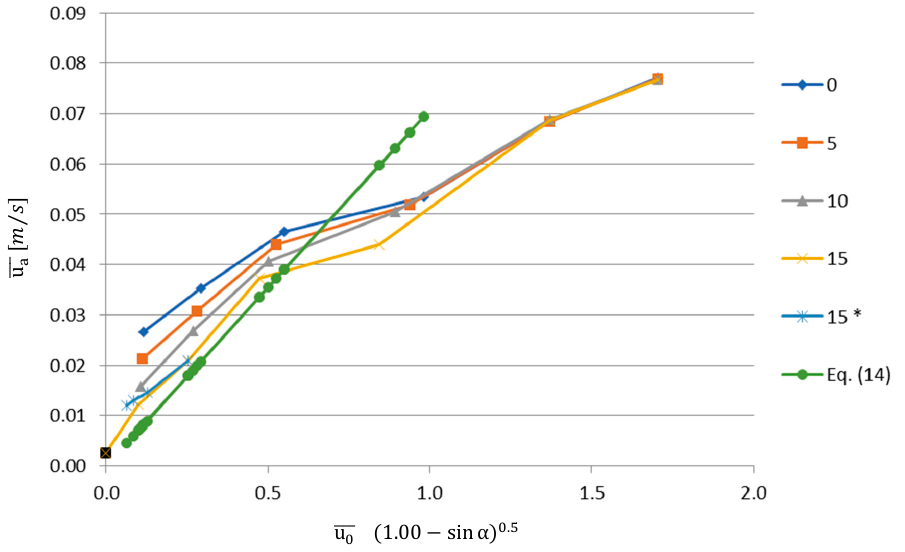
Figure 16. Comparison between experimental results and Equation (14).